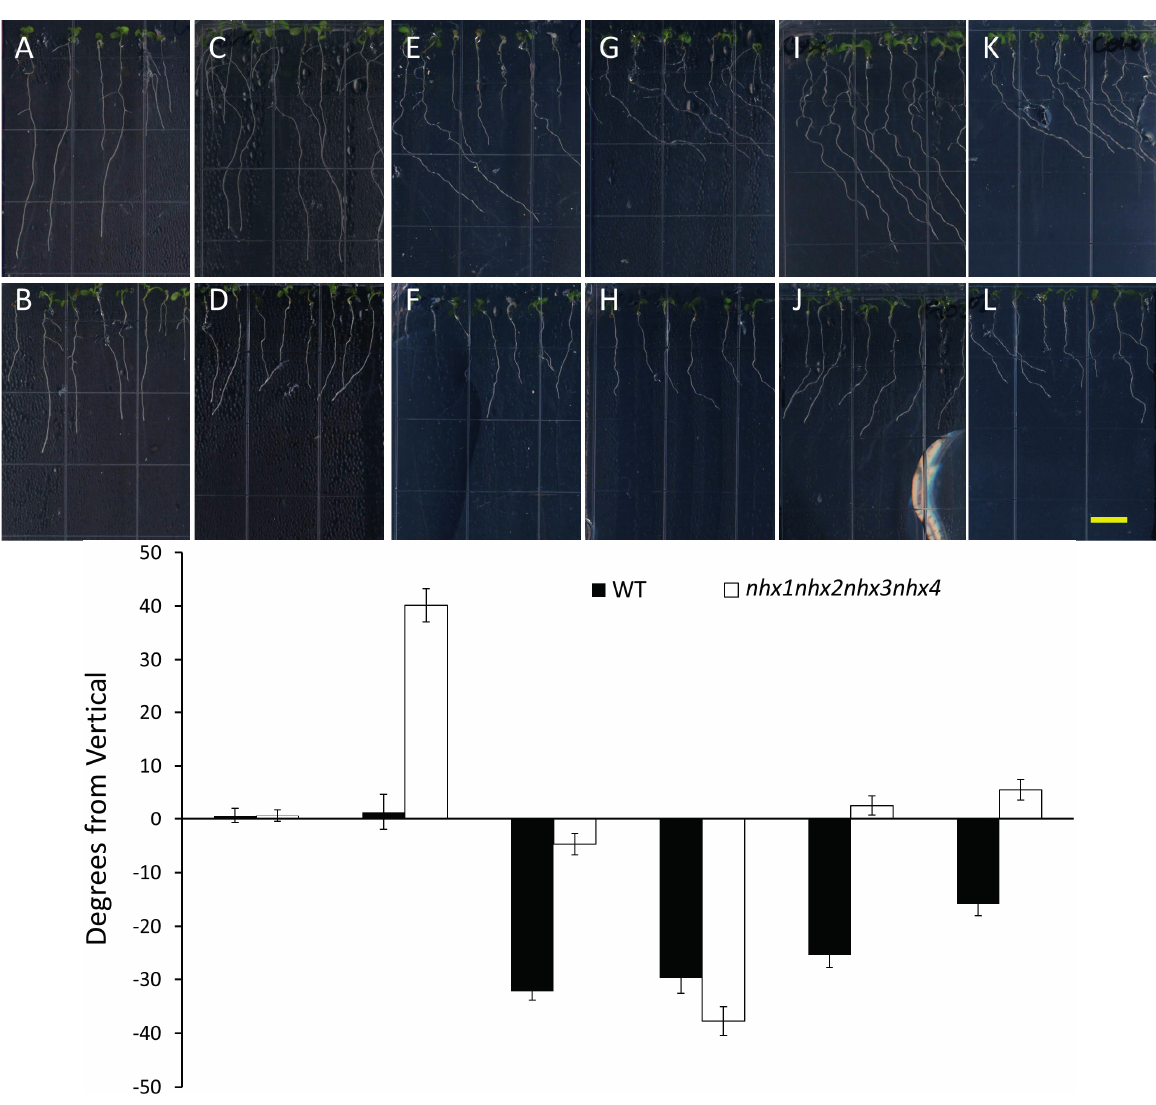
Figure 5. Taxol reverses directional root growth in nhx1nhx2nhx3nhx4 grown on potassium-supplemented media. Wild-type ( top ) and nhx1nhx2nhx3nhx4 ( bottom ) seedlings were germinated on minimal media containing 1 mM K + for three days and transferred to plates containing two concentrations of Taxol and K + (indicated below) and grown for an additional four days. ( A , B) 1 mM K + ; ( C , D ) 30 mM K + ; ( E , F ) 0.5 µM Taxol and 1 mM K + ; ( G , H ) 1 µM Taxol and 1 mM K + ; ( I , J ) 0.5 µM Taxol and 30 mM K + ; ( K , L ) 1 µM Taxol and 30 mM K + . ( M ) The angle of root growth was quantified as the degrees from vertical; values represent the mean ± SE ( n = 24). The bar is 0.5